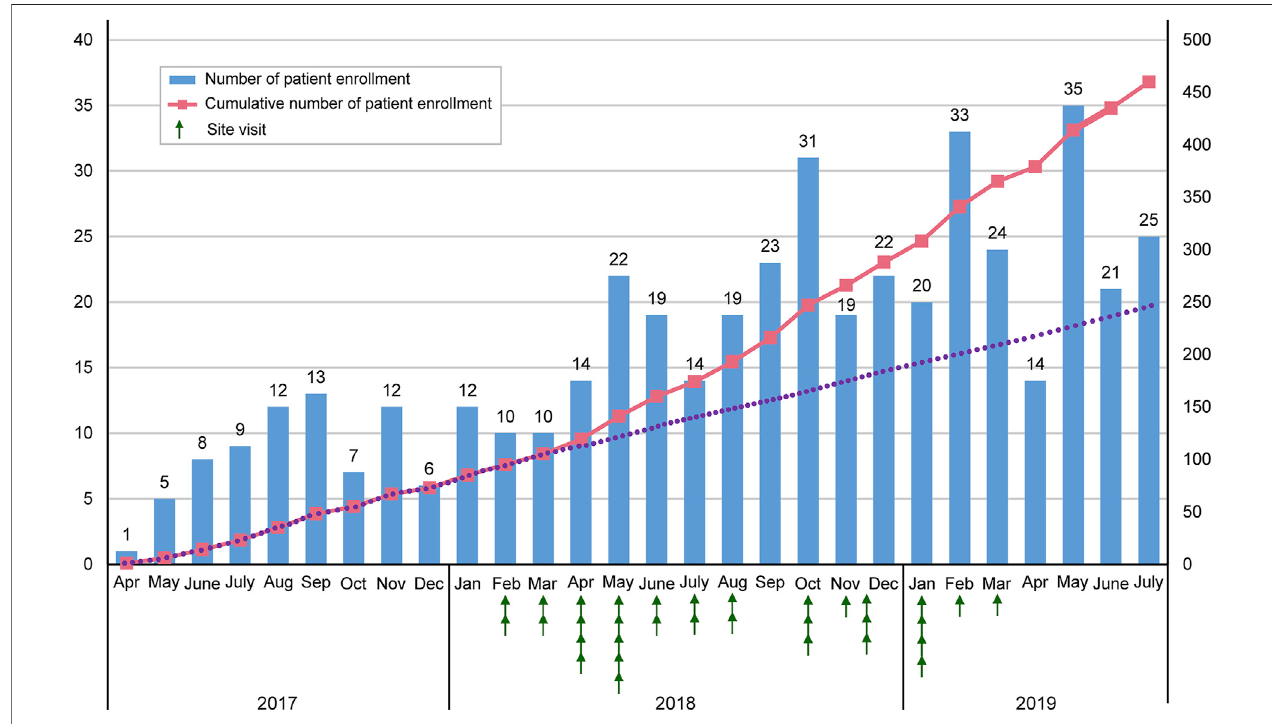
FIGURE 1 | Transition in the number of enrolled